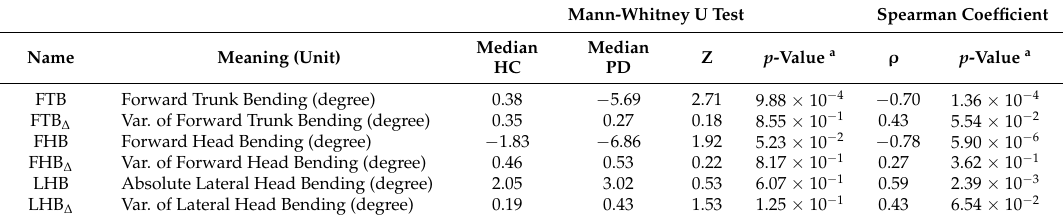
Table 7. Parameters of the Po task: discriminant power and correlation with UPDRS